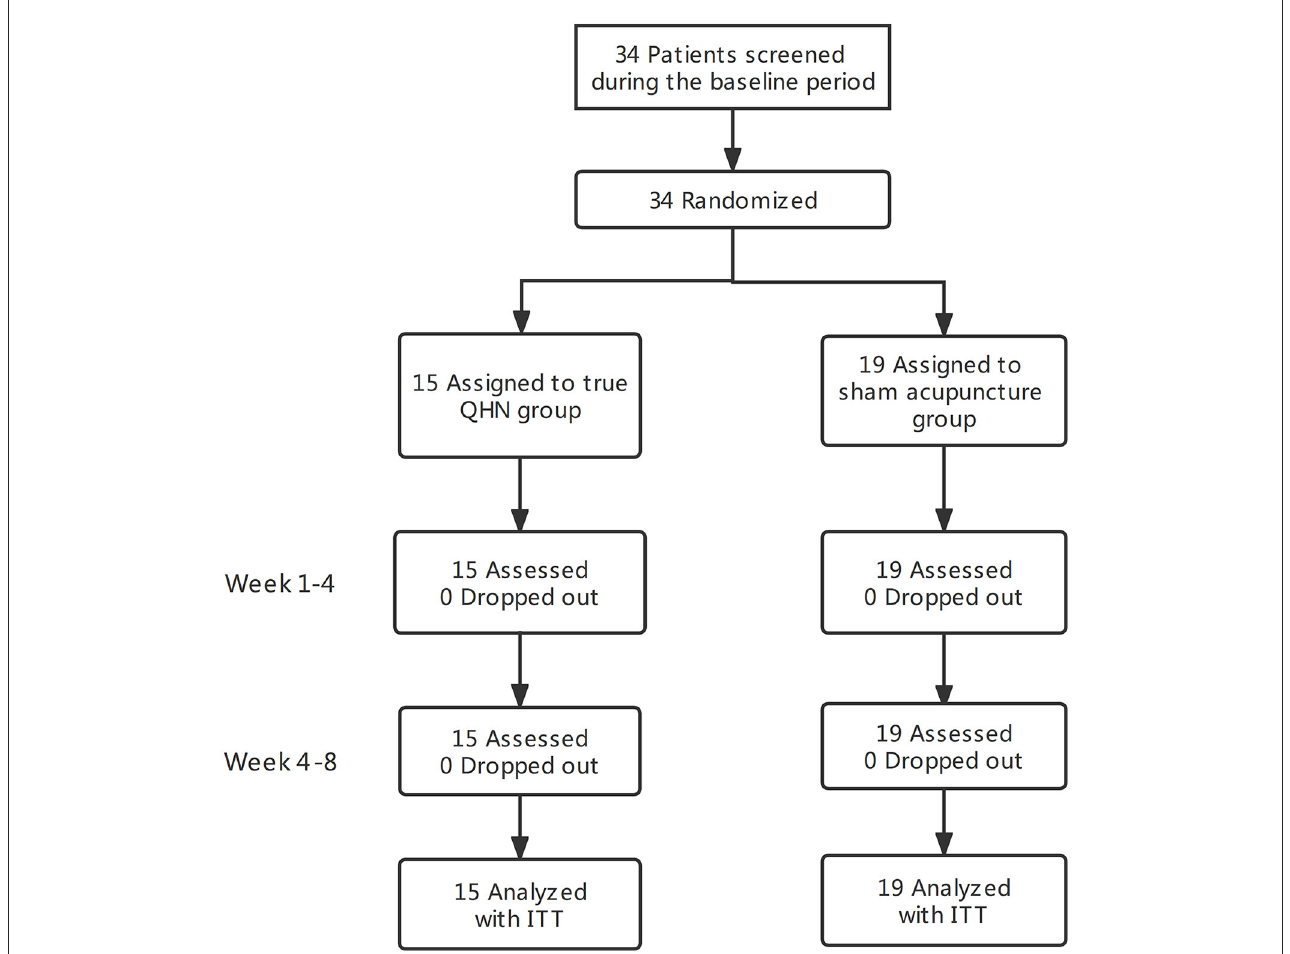
FIGURE1 A flowchart of the screening, enrollment, randomization, and follow-up of this study.